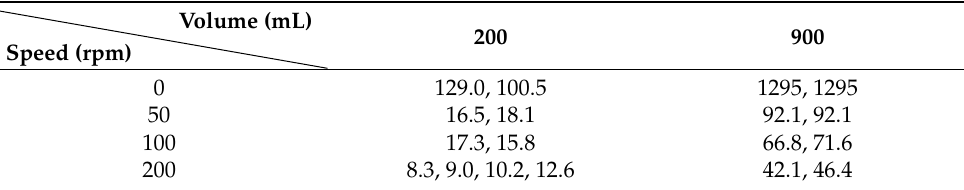
Table 6. Mass-transfer time constants (hours) for 0.3 g benzoic acid tablets dissolved in deionized water (USP dissolution apparatus